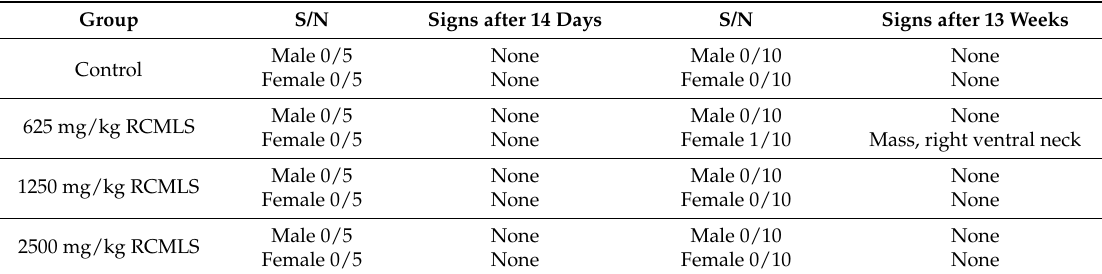
Table 3. Mortality and clinical sign of 14 days repeated oral dose and 13 weeks repeated oral dose toxicity studies of the leaves and stems of Rubus coreanus Miquel (%).